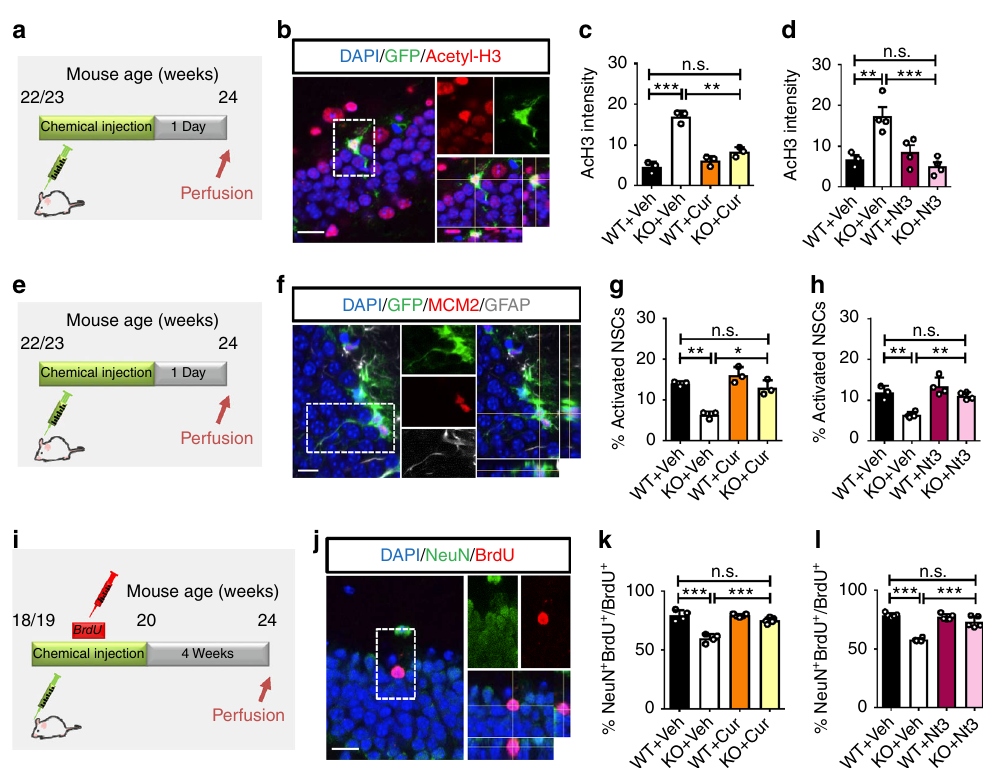
Fig. 6 Rebalancing histone acetylation rescues neurogenic de fi cits in Fmr1 KO mice. a , e Experimental schemes for assessing histone acetylation ( a ) and NSC activation ( e ) in WT and Fmr1 KO mice treated with curcumin, Nutlin-3, or vehicle. b Sample confocal images of acetylated histone H3 in the NSCs of 6-month-old WT and Fmr1 KO-Nes-GFP mice. Blue, DAPI; green, GFP; red, acetyl-H3. Scale bar, 20 µ m. c , d Curcumin treatment ( c , n = 3 mice per group) or Nutlin-3 ( d , n = 3 to 4 mice per group) reduced histone H3 acetylation in GFP + NSCs Fmr1 KO mice without affecting WT mice. f Sample confocal images of activated NSCs (GFP + GFAP + MCM2 + ) in the dentate gyrus of 6-month-old WT or Fmr1 KO (Nes-GFP) mice. Blue, DAPI; green, GFP; red, MCM2. Scale bar, 20 µ m. g , h Curcumin ( g , n = 3 to 4 mice per group) or Nutlin-3 treatment ( h , n = 3 mice per group) rescued NSC activation in Fmr1 KO mice. i Experimental scheme for assessing neuronal differentiation in WT and Fmr1 KO mice treated with curcumin, Nutlin-3, or vehicle. j Sample confocal images of newborn neurons (DAPI + NeuN + BrdU + ) in the dentate gyrus of WT and Fmr1 KO mice. Blue, DAPI; green, NeuN; red, BrdU. Scale bar, 20 µ m. k , l curcumin ( k , n = 4 to 5 mice per group) or Nutlin-3 treatment ( l , n = 4 to 5 mice per group) rescued neuronal differentiation speci fi cally in Fmr1 KO mice. * P < 0.05, ** P < 0.01, *** P < 0.001, n.s.: no signi fi cant difference. Two-way ANOVA was used for all data analyses. Data are presented as mean ± s.e.m. The boxes with dotted white lines in b , f , j indicate regions where higher magni fi cation images are